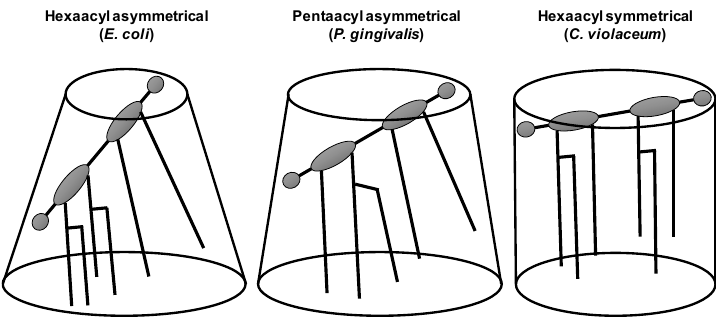
Figure 5. LPS macrostructure proposed for different lipid A moieties. (Modified from Seydel et al.